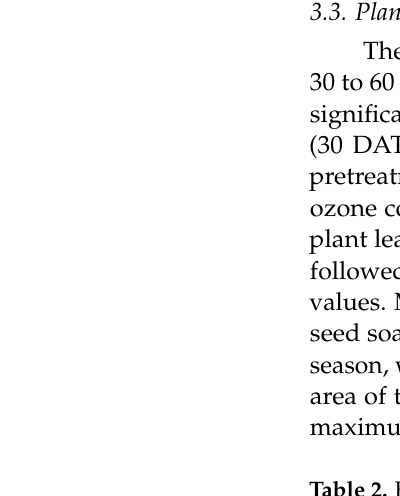
Table 2. Effect of ozone and chilling tolerance pretreatments on plant leaf area of two sweet pepper hybrids 30 and 60 days after transplanting during the 2017/18 and 2018/19